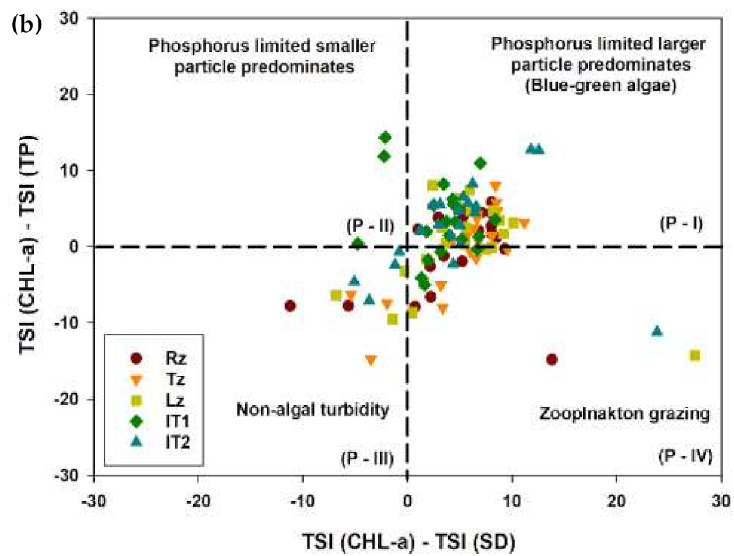
Figure 10. Trophic state index ( a ) and its deviation ( b ) based on TP, CHL-a and SD of Daecheong Reservoir. TP: total phosphorus; CHL-a: Chlorophyll-a; SD: Secchi depth; Rz: riverine zone; Tz: transitional zone; Lz: Lacustrine zone; IT 1 and IT 2 : intake tower of drinking water 1 and 2; red lines in the box indicate mean